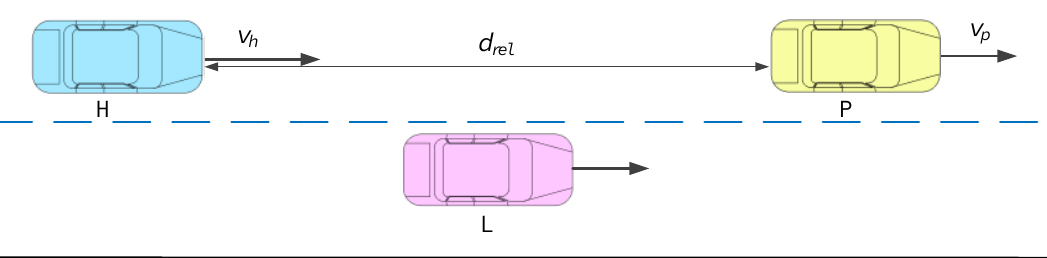
Figure 11. Sufficient relative distance.